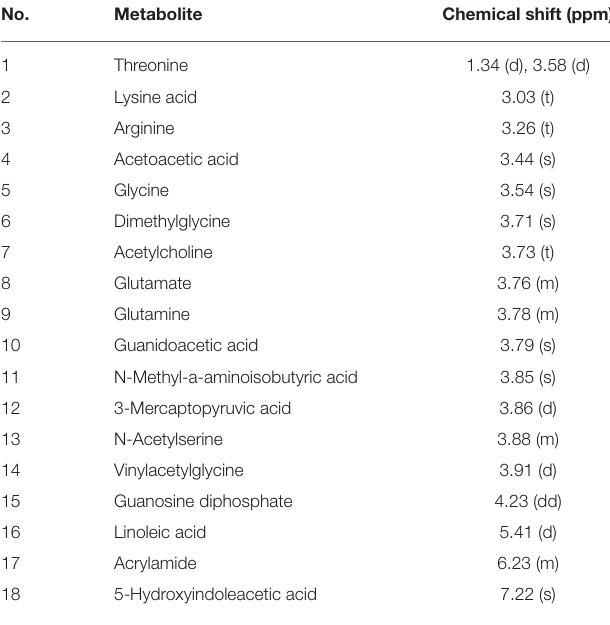
TABLE 2 | Distribution of 1 H-NMR peaks in control